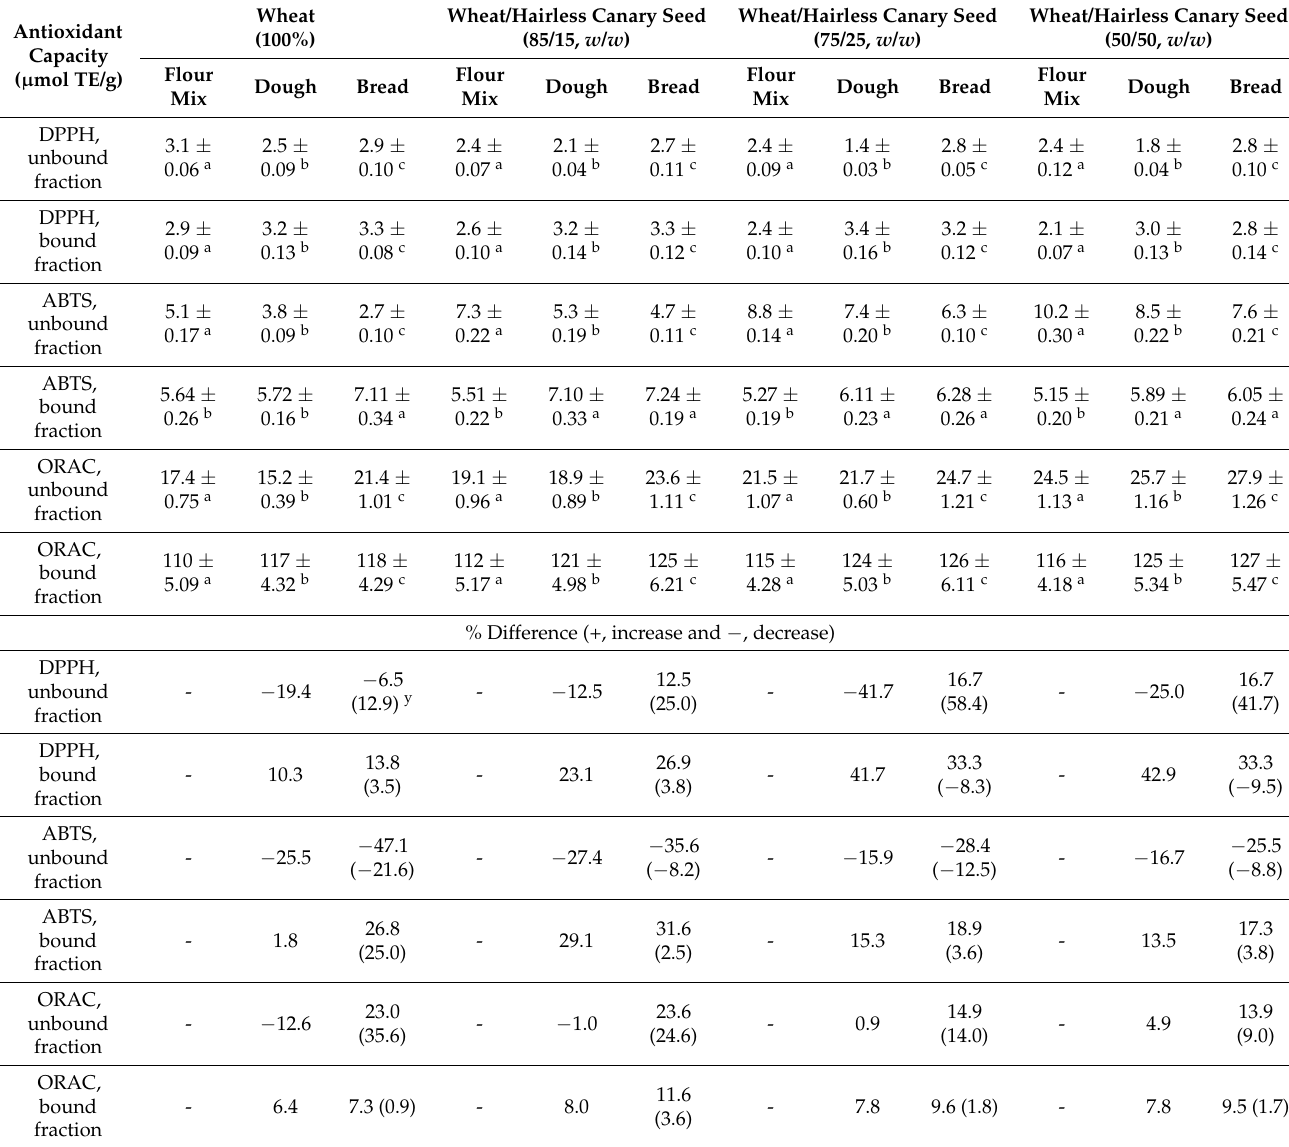
Table 3. Antioxidant properties of unbound and bound phenolic extracts of dry flour mix, dough, and fresh bread products and their influence by baking process x